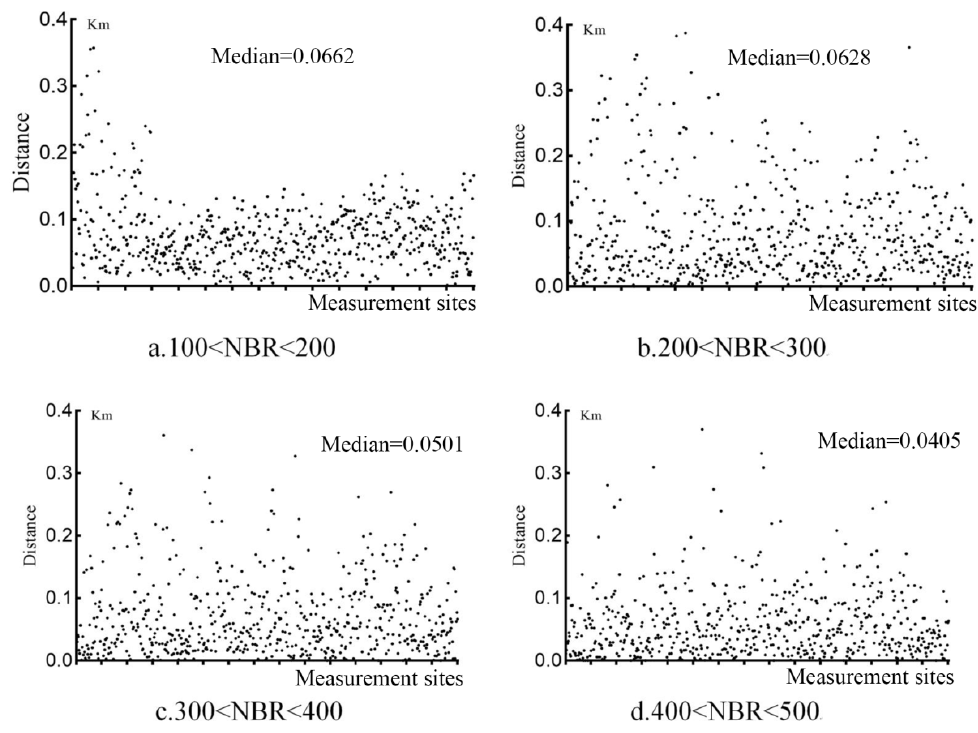
Figure 7. Spatial distance between different land use volatility. The abscissa shows the measurement sites and the ordinate is the distance from the measurement sites to the areas with NBR change greater than 500. Each point represents a measurement under that group classification.